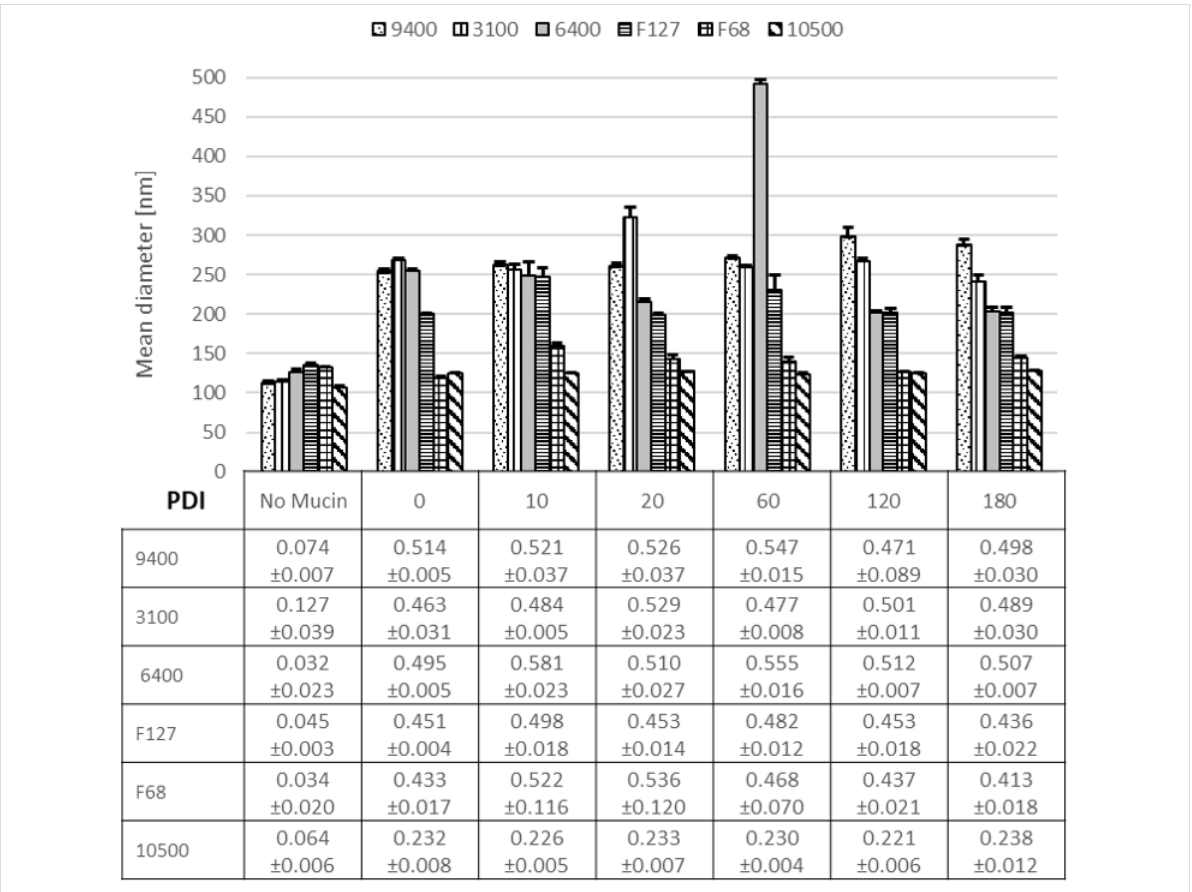
laminar flow conditions and longer mixing time. Higher